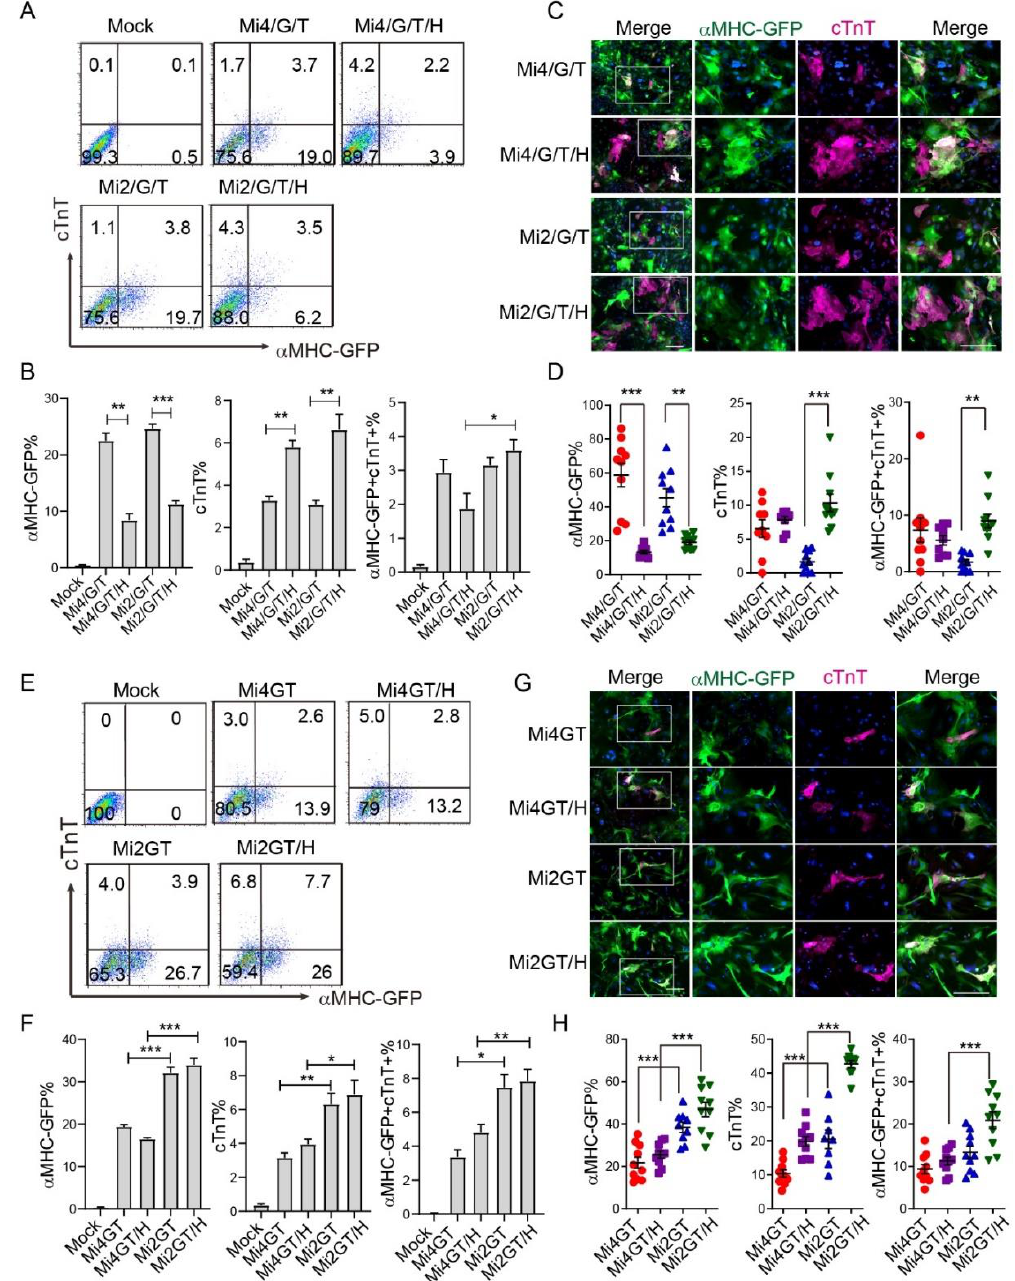
Figure 4. Role of Hand2 in different Mef2C isoforms mediated iCM reprogramming. ( A ) Representative flow cytometry plots of cTnT+, αMHC-GFP+, and double positive iCMs generated from MEF using Mi2/G/T or Mi4/G/T separate vectors plus Hand2. ( B ) Quantification of the flow cytometry data. ( C ) Representative ICC images of iCMs generated using M/G/T separate vectors plus Hand2. ( D ) Statistical analysis of the ICC data in C. ( E ) Representative flow cytometry plots of cTnT+, αMHC-GFP+, and double positive iCMs generated from MEF using polycistronic Mi2GT or Mi4GT constructs plus Hand2 vector. ( F ) Quantification of the flow cytometry data in ( E ). ( G ) Representative ICC images of iCMs generated using polycistronic MGT constructs plus Hand2; ( H ) Statistical analysis of the ICC data in G. Scale bar, 200 μm. For each experiment, n = 3–4; averaged numbers from technical triplicates, or at least 10 random ICC fields were used for statistics. All data are mean ± SEM. Statistical analysis was performed with one-way ANOVA followed by Tukey’s test. * p < 0.05, ** p < 0.01, *** p < 0.001.